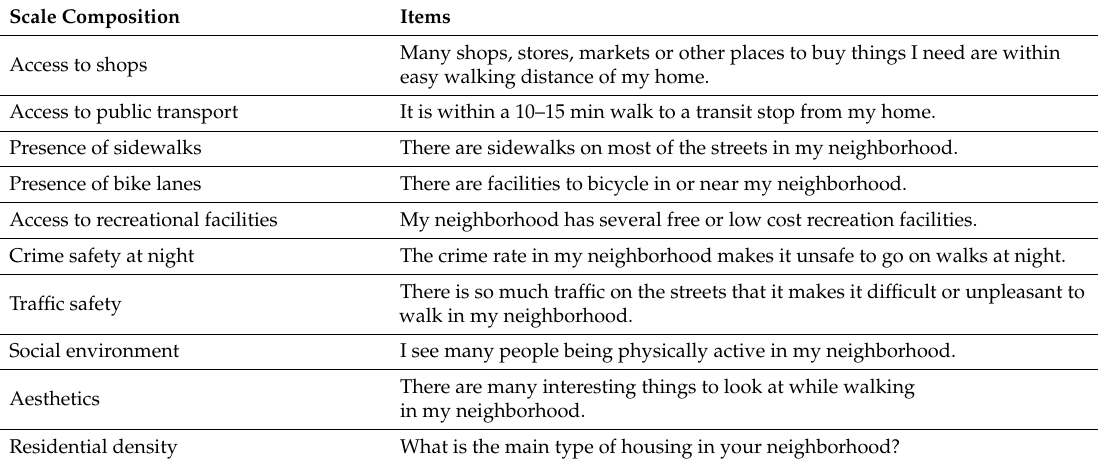
Table 1. Items of international physical activity questionnaire environmental